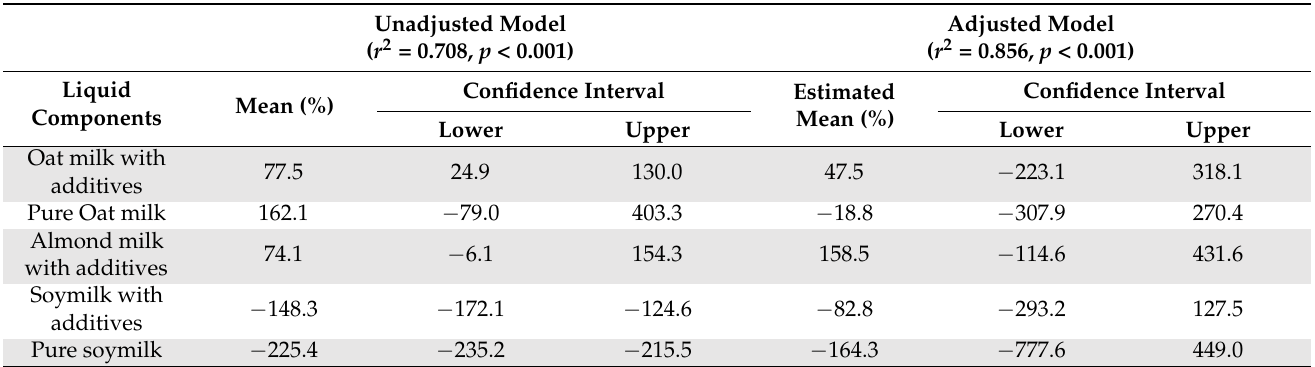
Table 5. Improvement in lutein liberation per gram of fat before and after adjustment for protein and fibers.